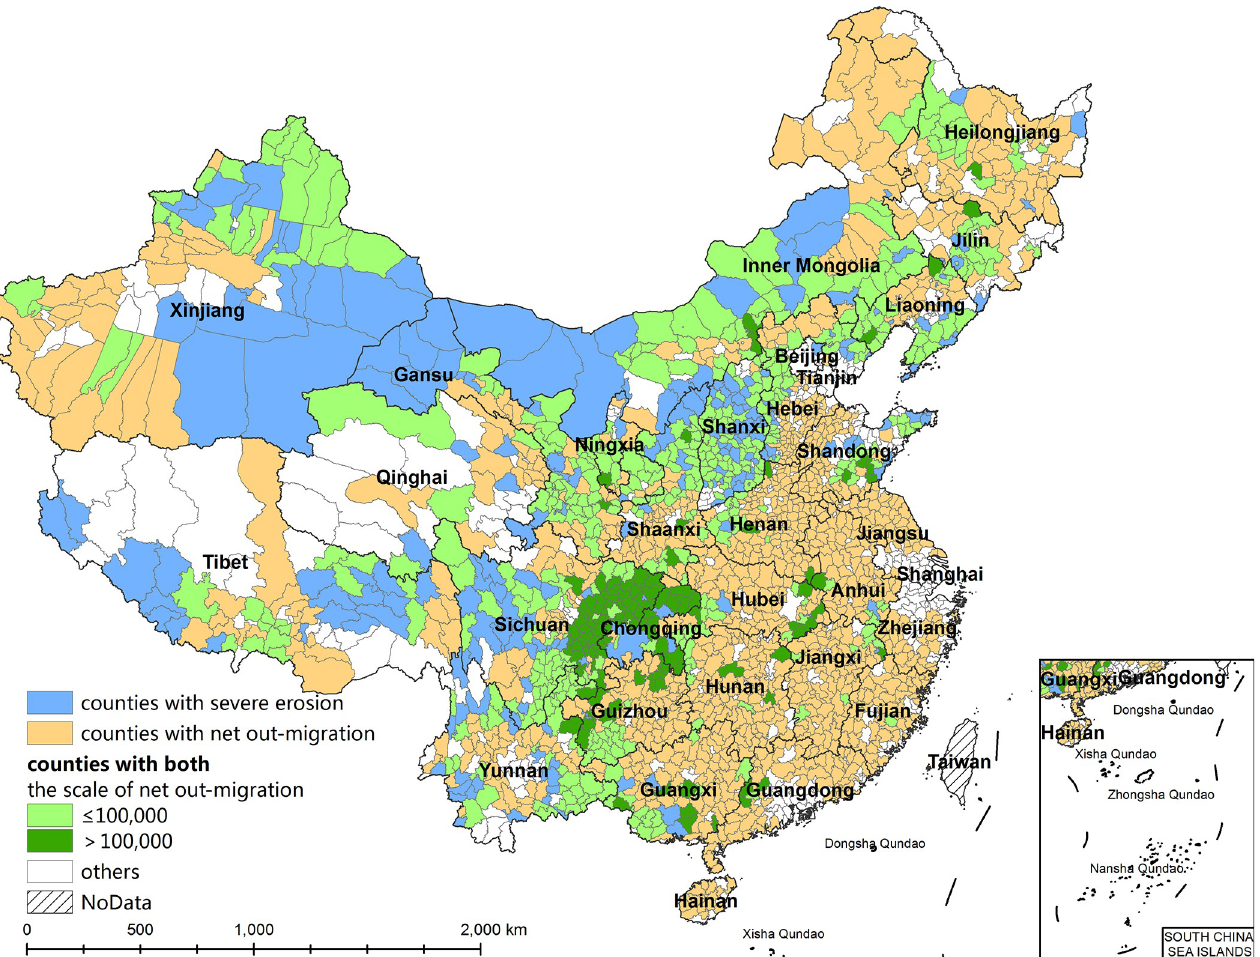
Fig 4. The spatial matching relationship between counties with severe erosion and counties with net outmigration in China.